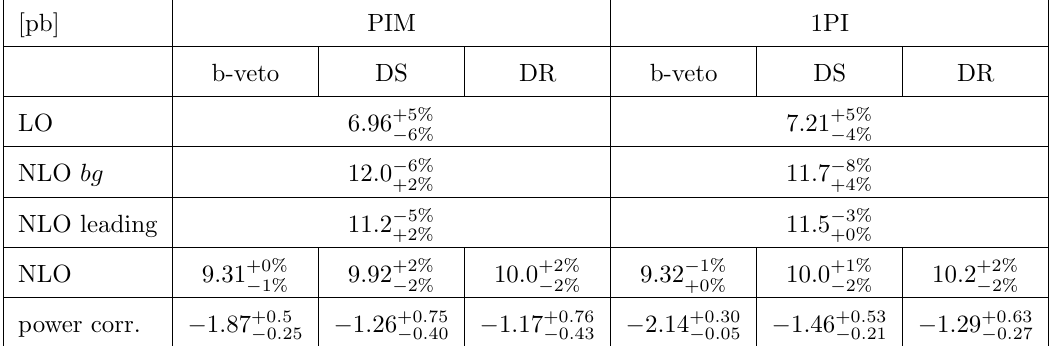
d(cid:27) (NLO leading). The LO results are (cid:0)